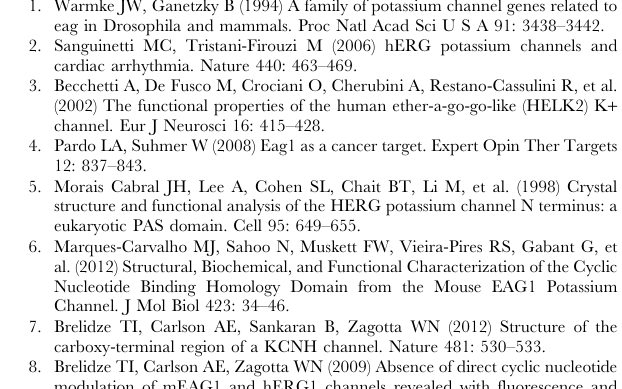
Figure 7. Superposition of three (in red, yellow and cyan C a trace) of the NMR model structures of the hERG PAS domain (PDB code 1L0W). Cavities detected in the three models are shown as red, yellow or cyan